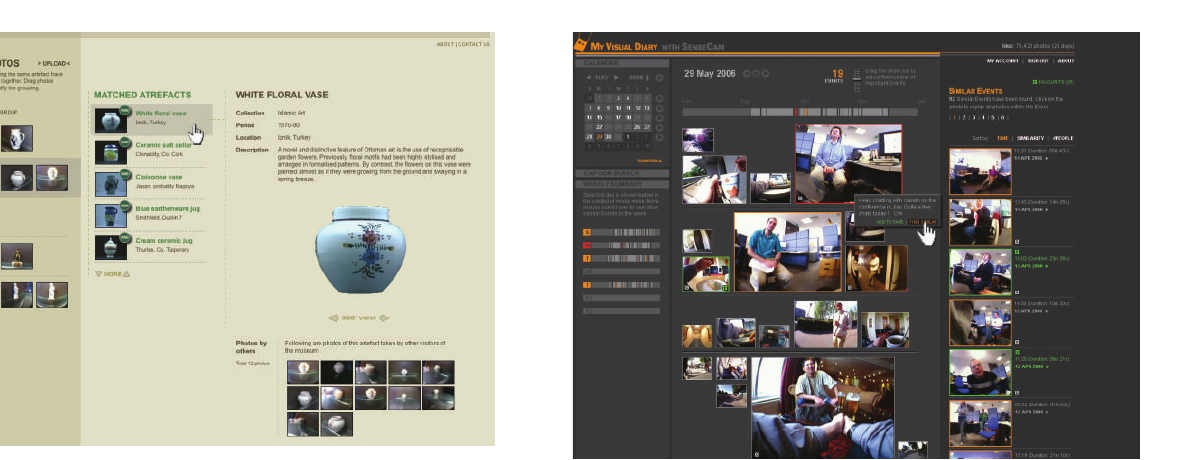
Figure 3: Reviewing the day’s highlights and viewing the past events similar to a particular event from